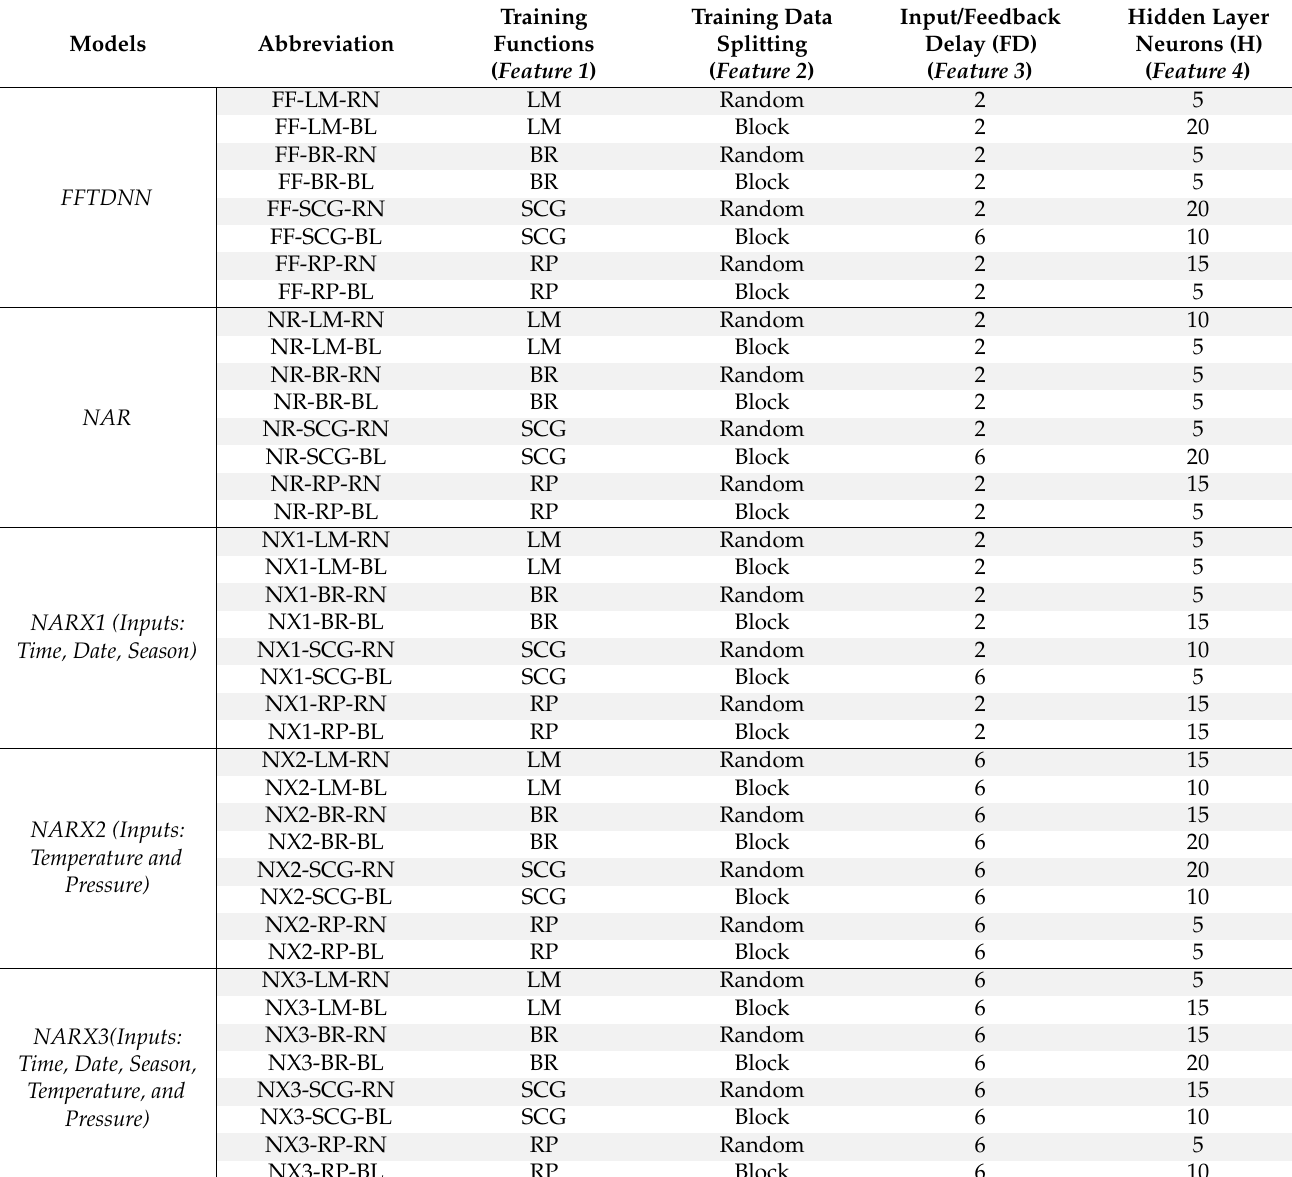
Table 1. A list of 40 configurations that were used to train and tune the five neural network models.